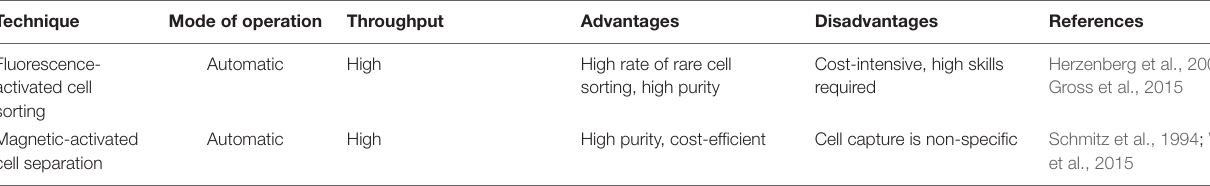
TABLE 2 | Commonly used methods for cell isolation based on biological characteristics.